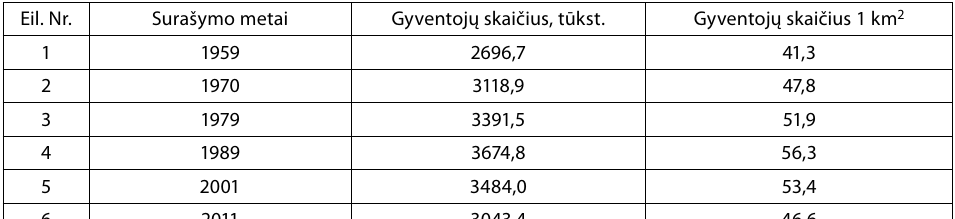
Table 3. The population and its density according data of lithuania statistics department Eil. nr.